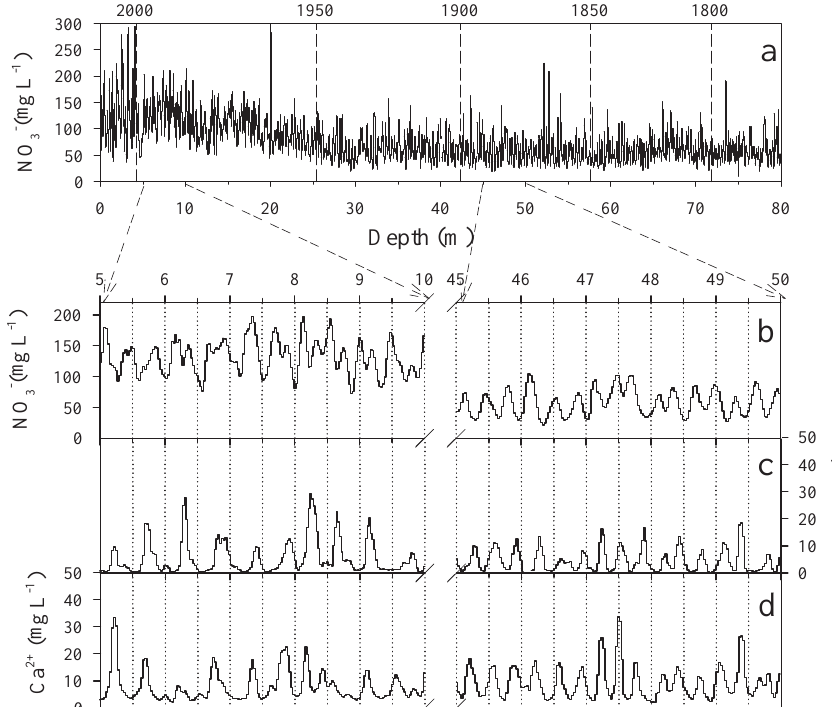
, Na + and Ca 2 + , respectively, in 3